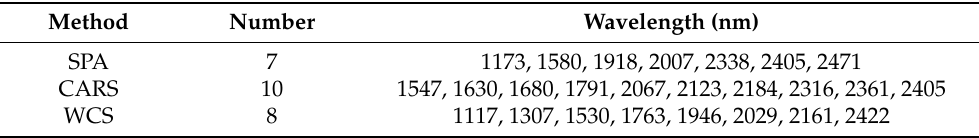
Table 3. Key wavelengths selected by SPA, CARS and WCS.